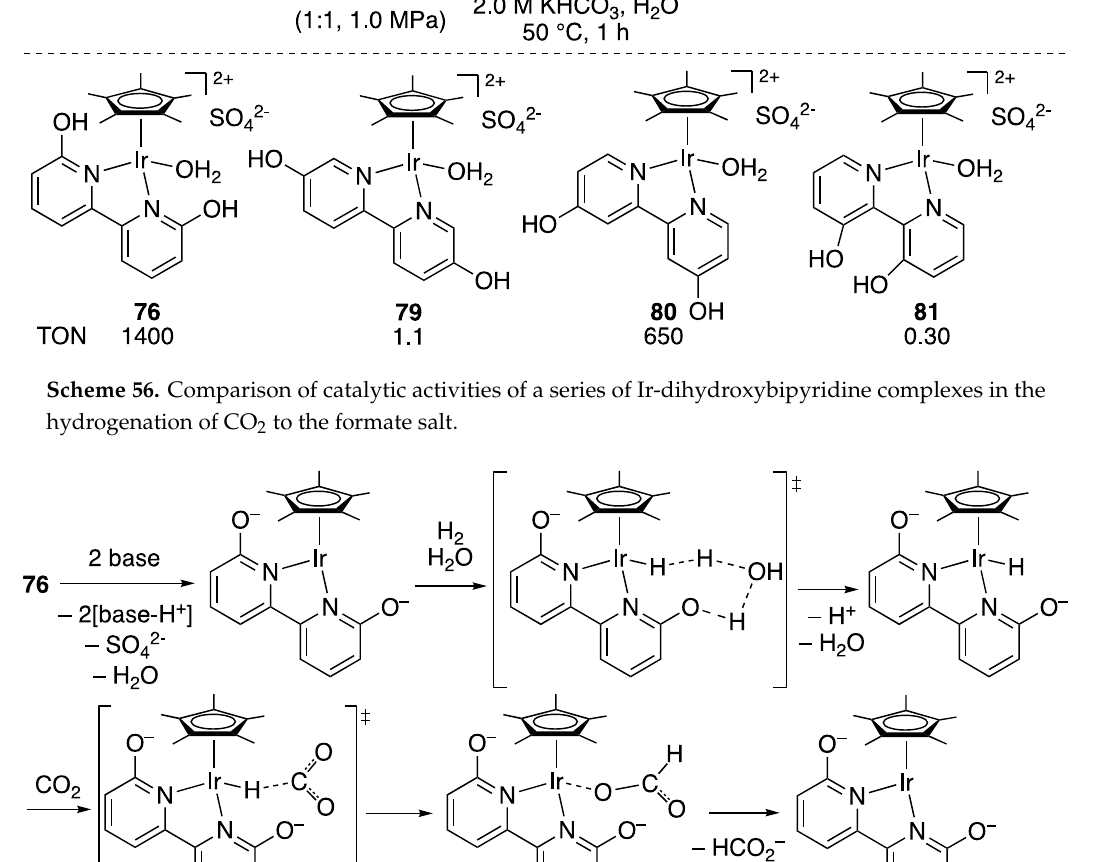
Figure 5. Ru and Mn complexes bearing hydroxypyridine-based ligands for the catalytic hydrogenation of CO 2 . 3.1.3. N -Heterocycle Hydrogenation The hydrogenation of aromatic N -heterocyclic compounds is a synthetically important transformation which facilitates access to various nitrogen-containing cyclic compounds including alkaloids, pharmaceuticals, and agrochemicals, which exhibit significant biological activities [142]. Furthermore, this transformation has recently garnered significant attention from the standpoint of hydrogen storage based on organic hydrides [205,206]. Metal–ligand cooperative catalysis can provide an efficient reaction pathway with a lower activation energy for this type of reaction. In 2009, we demonstrated the good catalytic performance of a Cp*-Ir pyridonate complex in the hydrogenation of quinoline derivatives leading to 1,2,3,4-tetrahydroquinolines [207]. Subsequent to